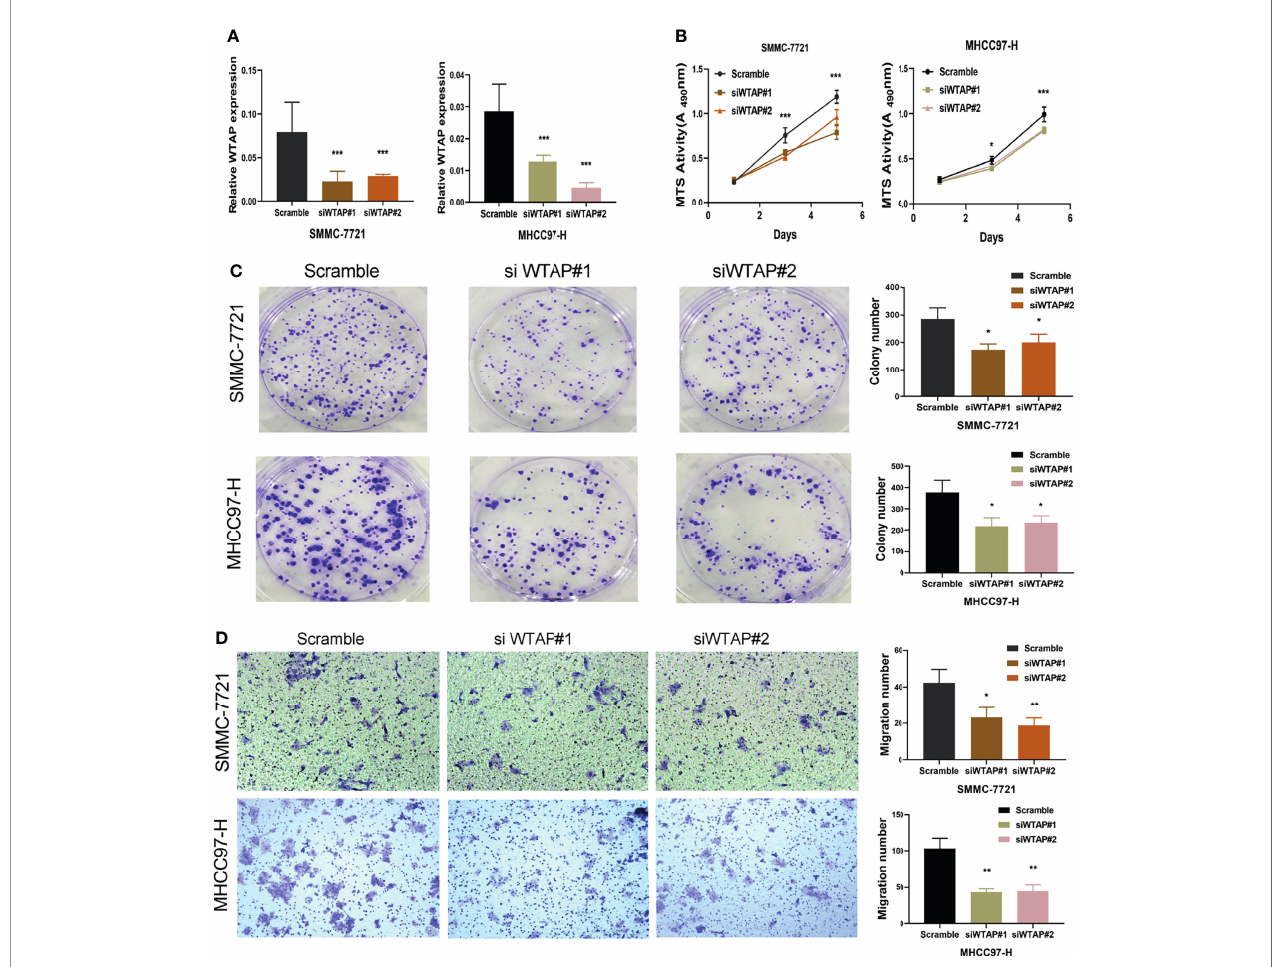
FIGURE 7 | Knockdown of WTAP inhibited the proliferation and migration of hepatocellular carcinoma cells. (A) SMMC-7721 and MHCC97-H cells were transfected with si-WTAP, and WTAP levels were evaluated by qRT-PCR. (B, C) Proliferation of SMMC-7721 and MHCC97-H cells was examined using MTS and colony formation assays. (D) Migration of hepatocellular carcinoma cells was examined using Transwell assays. * P < 0.05, ** P < 0.01 and *** P < 0.001